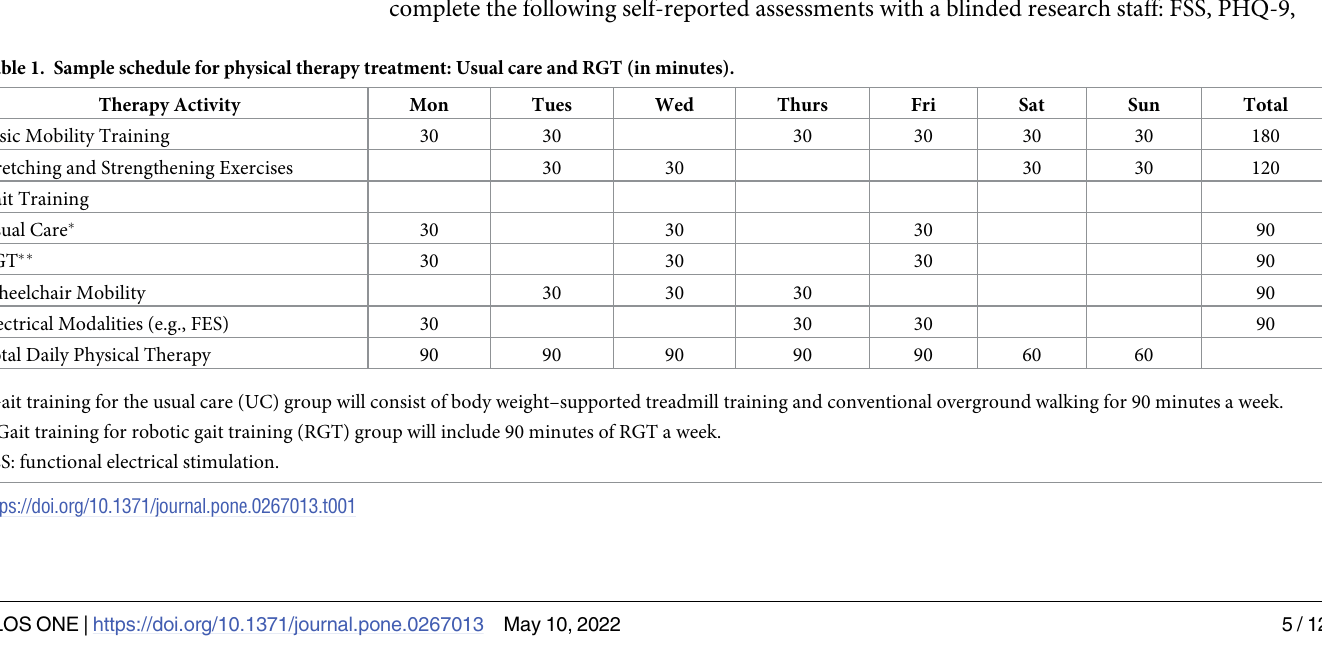
Table 1. Sample schedule for physical therapy treatment: Usual care and RGT (in minutes). Therapy Activity Mon Basic Mobility Training Stretching and Strengthening Exercises